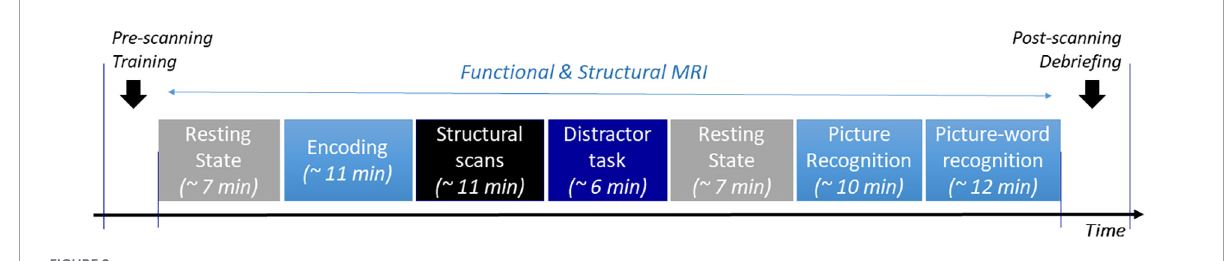
FIGURE2 Overall procedure. Description and durations of the different consecutive stages that participants had to follow while inside the MRI scanner.